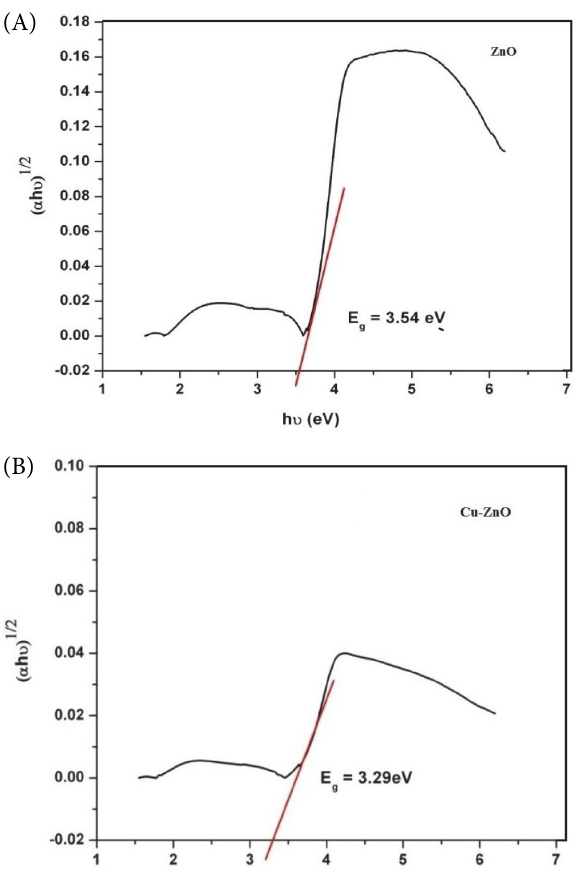
Figure 2. (A) and (B) τ-Plot of ZnO, and Cu-ZnO NPs